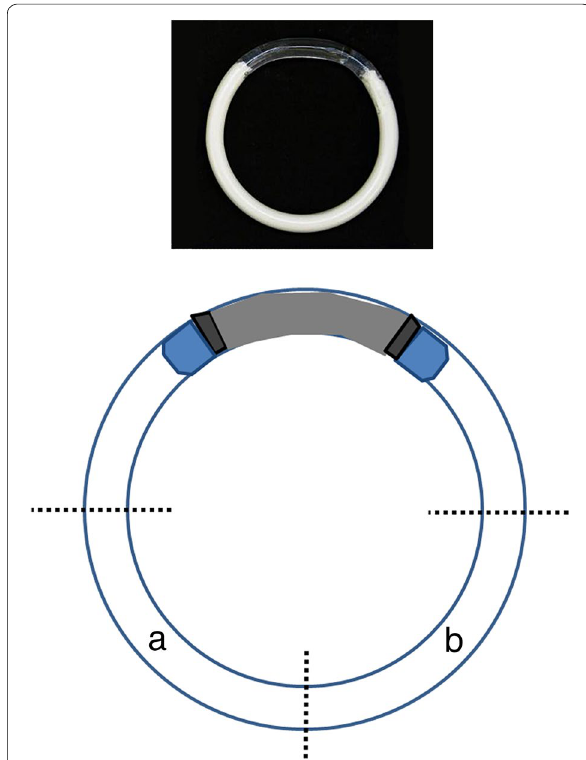
Fig. 1 Schematic of IVR extractions. The IVR was cut horizontally across, and the resulting bottom half was cut into two portions. From one portion, ( a ) glycerin was extracted and from the other ( b ) bioanalytes were extracted. A photo of the IVR is shown on